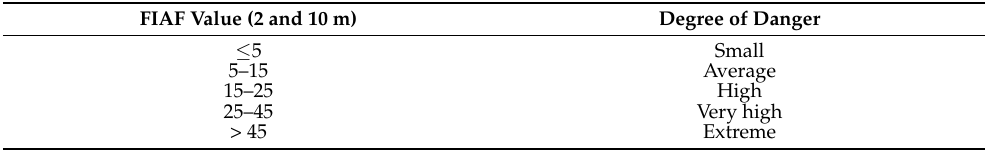
Table 1. FIAF values (2 and 10 m) and classification according to the degree of fire danger in Itatiaia National